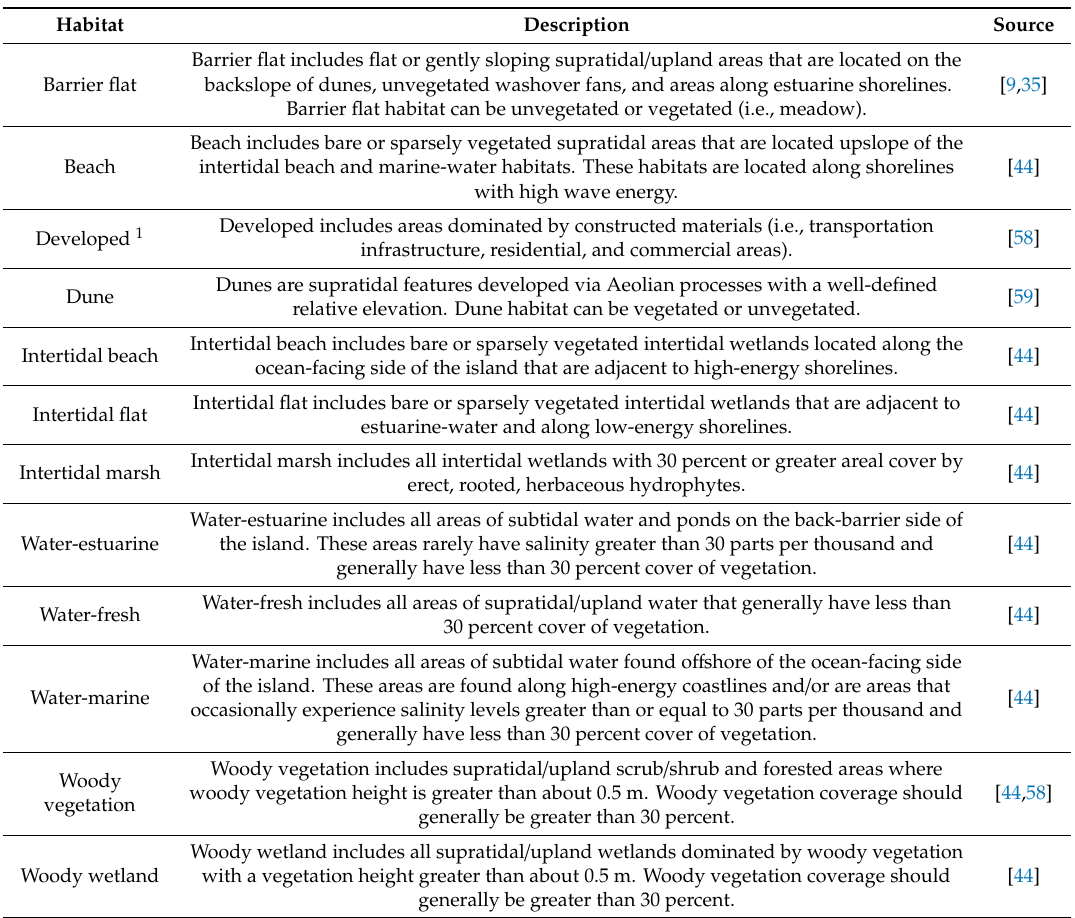
Table A1. Descriptions of the habitat classes included in the habitat model for Dauphin Island, Alabama,